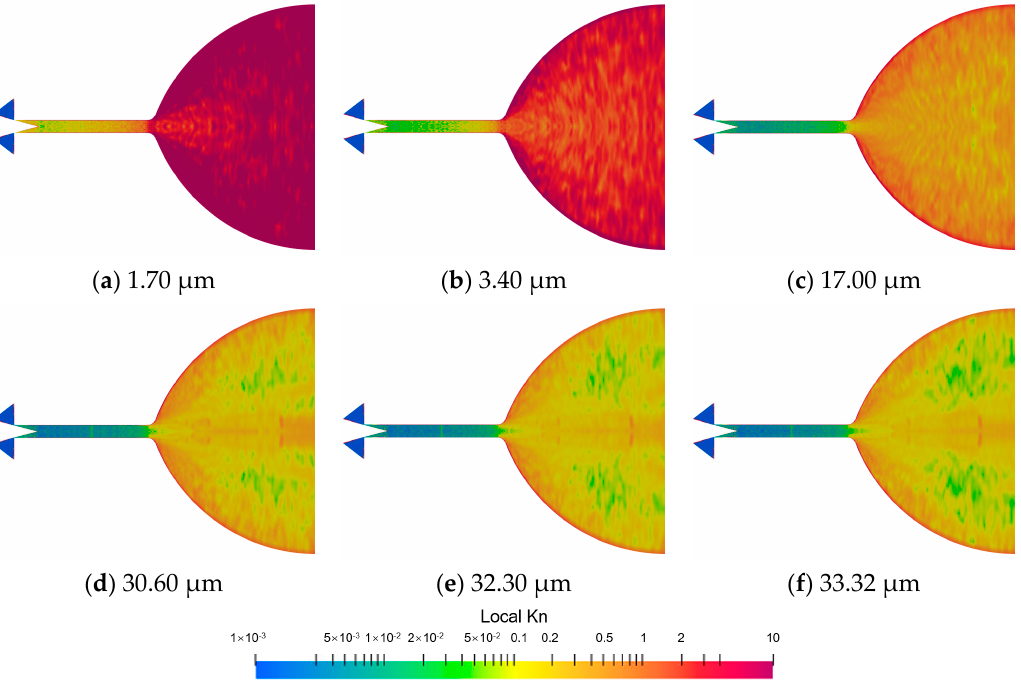
Figure 13. Local Kn distributions in the axial plane with different needle displacements at t = 0.1 ms. The black area is continuous non ‐ slip flow, and the red area is free molecular flow. The slip flow and transition flow are distributed between the above two regions .